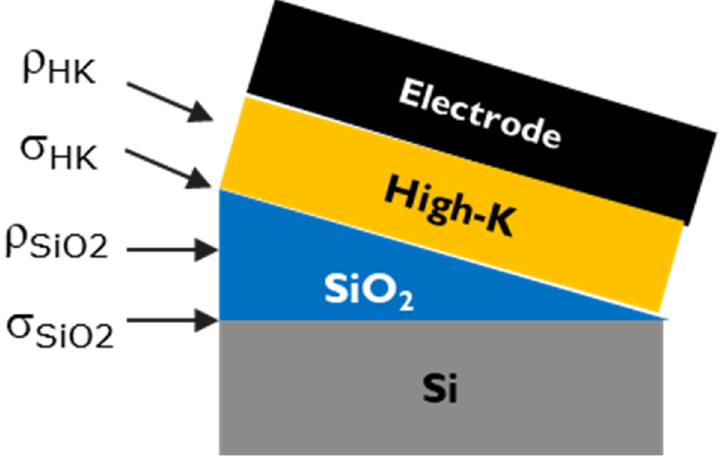
Figure 3. Schematic of MIS capacitor with slant etch for SiO 2 . Corresponding oxide charge densities are